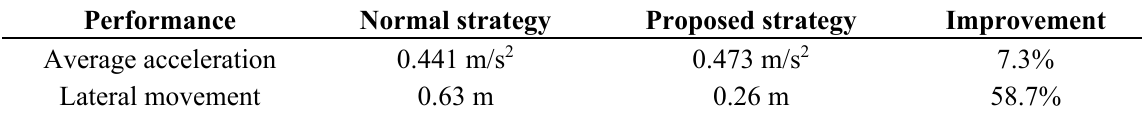
Figure 17. Comparison of experiment results of the proposed strategy and normal strategy on a low friction t road: ( a ) lateral movement and ( b ) acceleration performance. Table 8. Performance of acceleration slip regulation on a low friction road